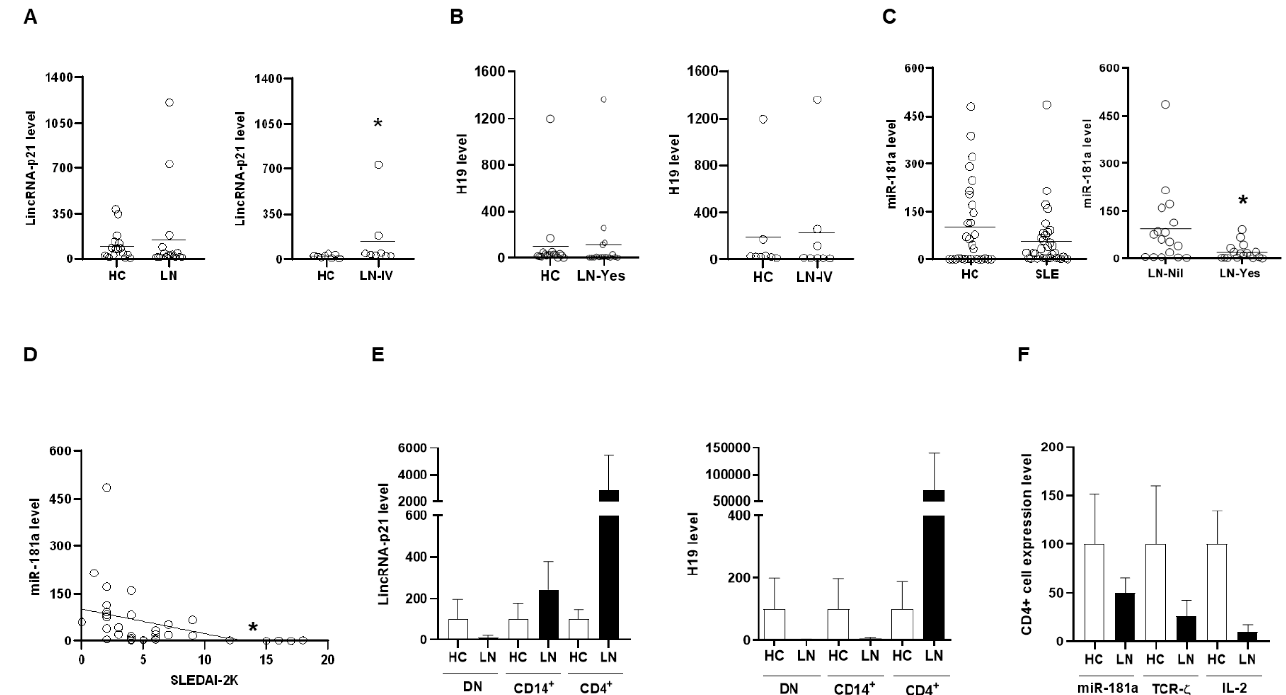
Figure 2. Up-regulated expression of lincRNA-p21 in urine cells and down-regulated expression of miR-181a in PBMNCs from LN patients. ( A ) LincRNA-p21 levels in urine cells from HCs and LN patients or IV histopathology. ( B ) H19 levels in urine cells from HCs and LN patients or IV histopathology. ( C ) miR-181a expression in PBMNCs from HCs and SLE patients, and from SLE patients without renal involvement and LN patients. ( D ) A significant negative correlation between miR-181a levels and SLEDAI-2K scores. ( E ) LincRNA-p21 and H19 levels in PBMNCs subpopulations including DN, CD14+ and CD4+ cells from HCs and LN patients. ( F ) MiR-181a, TCR- ζ chain, and IL-2 levels in CD4+ cells from HCs and LN patients. Horizontal lines in ( A – C ) are mean values from HCs and patients. Data are expressed in mean with SEM in ( E , F ). n = 30 for HCs and n = 34 for SLE patients (in PBMNCs), n = 17 for HCs and LN patients (in urine cells), n = 8 for HCs and IV histopathology (in urine cells), n = 3 for HCs and LN patients (in PBMNCs subpopulations), and n =3 for HCs and LN patients (in CD4+ cells). DN: double negative. * p < 0.05.